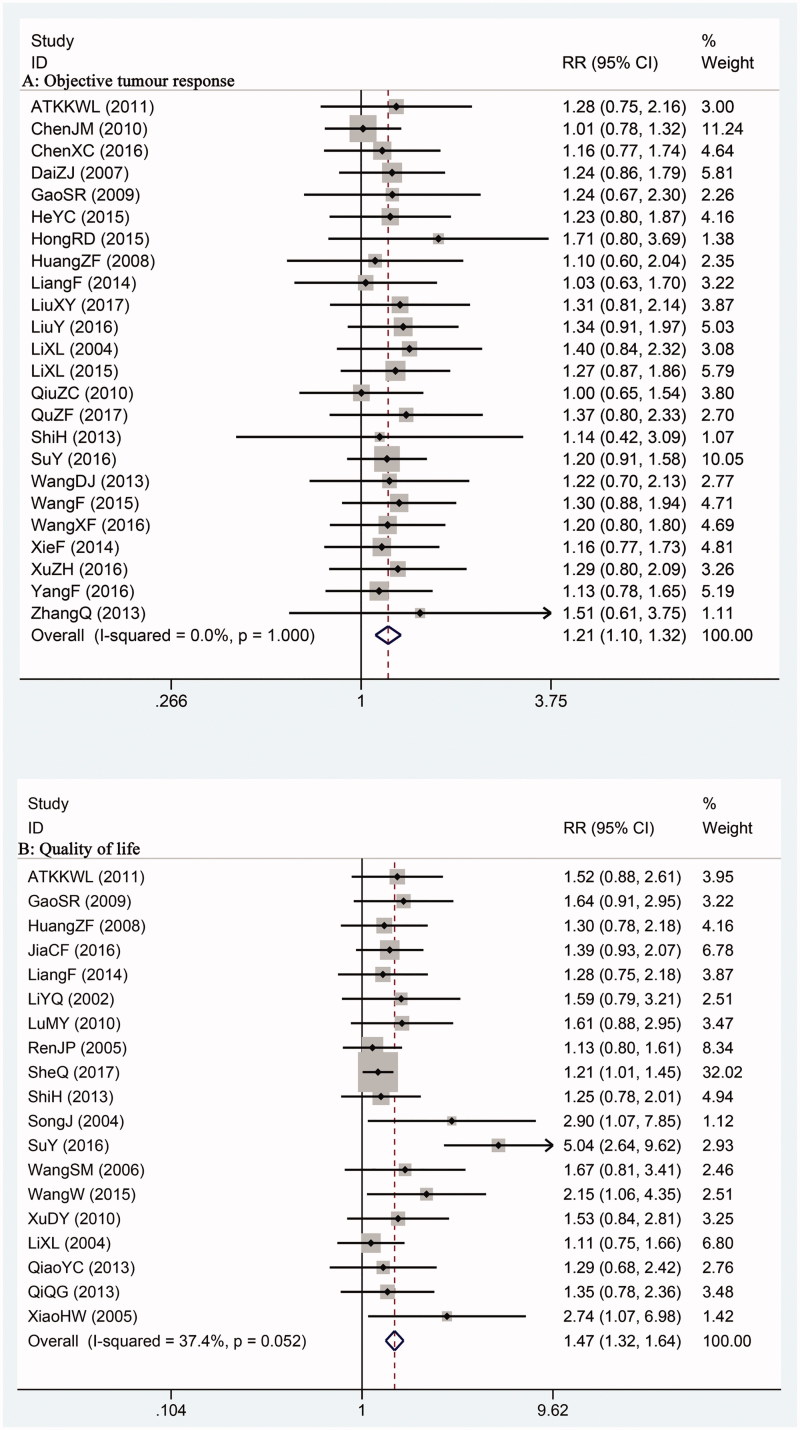
Comparison of objective tumor response rate (A) and performance status (B) between SFI intervention and control group.